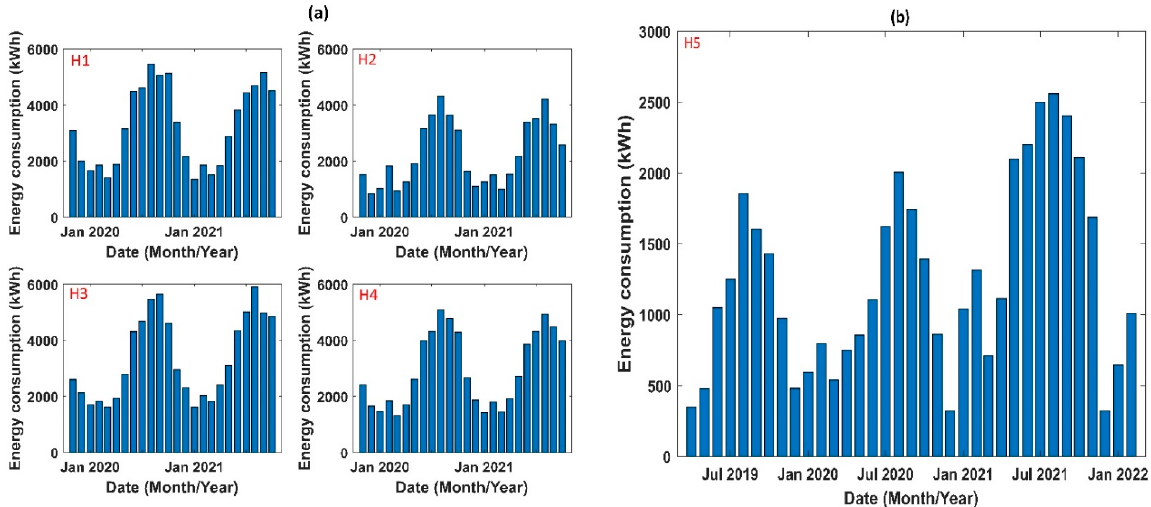
Figure 7. ( a ) Monthly energy consumption of different residential loads (H1 to H4) and ( b ) more recent data recorded for another residential load (H5) in the same local area.